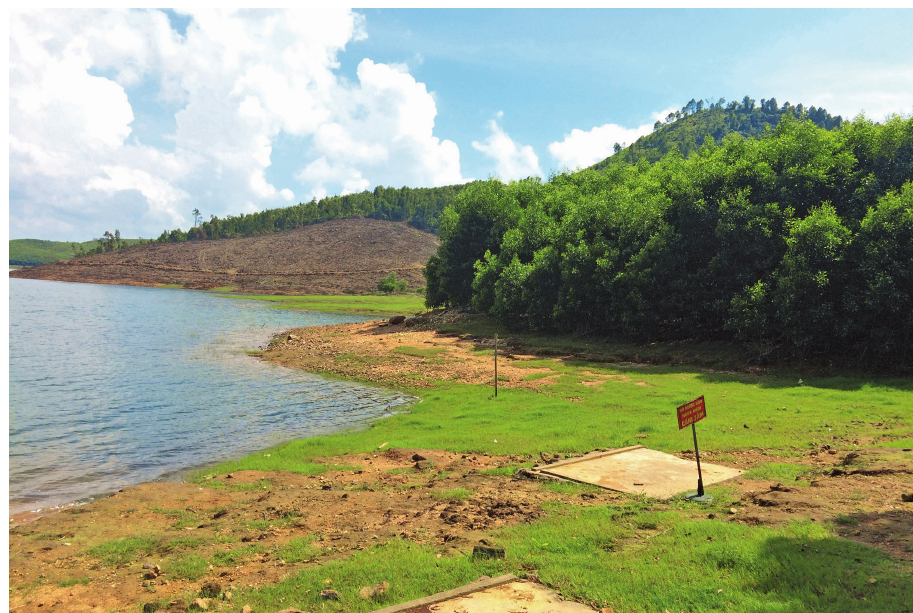
Figure 5. Habitat of Pelodiscus variegatus sp. n.: Song Rac Lake, Cam Xuyen District, Ha Tinh Province, Vietnam. Photograph An Vinh